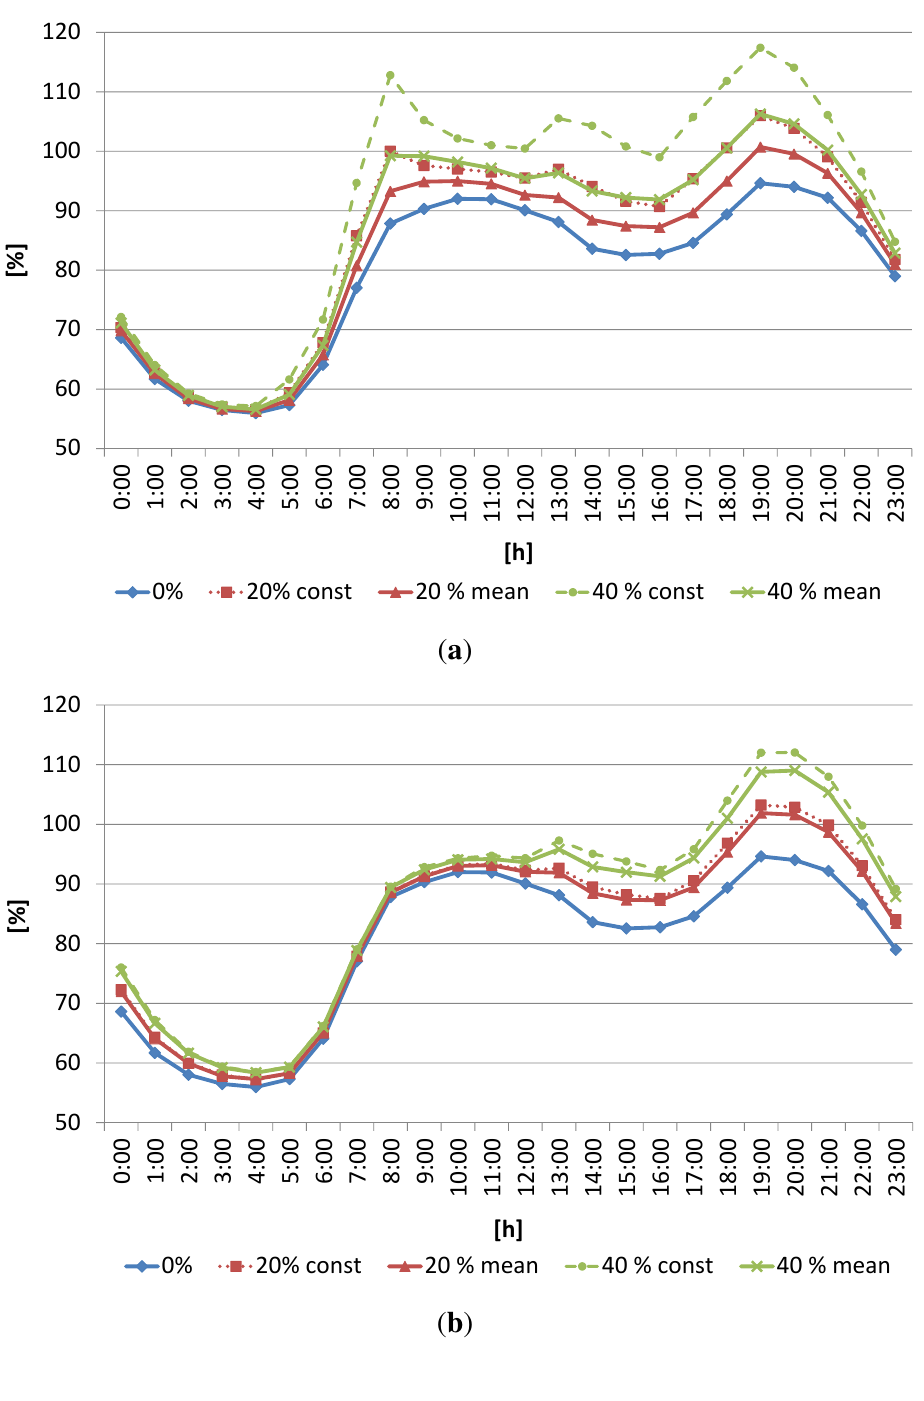
Figure 13. Loading profile of the transformers through a winter weekday. ( a ) Recharge of the battery at the end of each travel; ( b ) Recharge of the battery at the end of all day